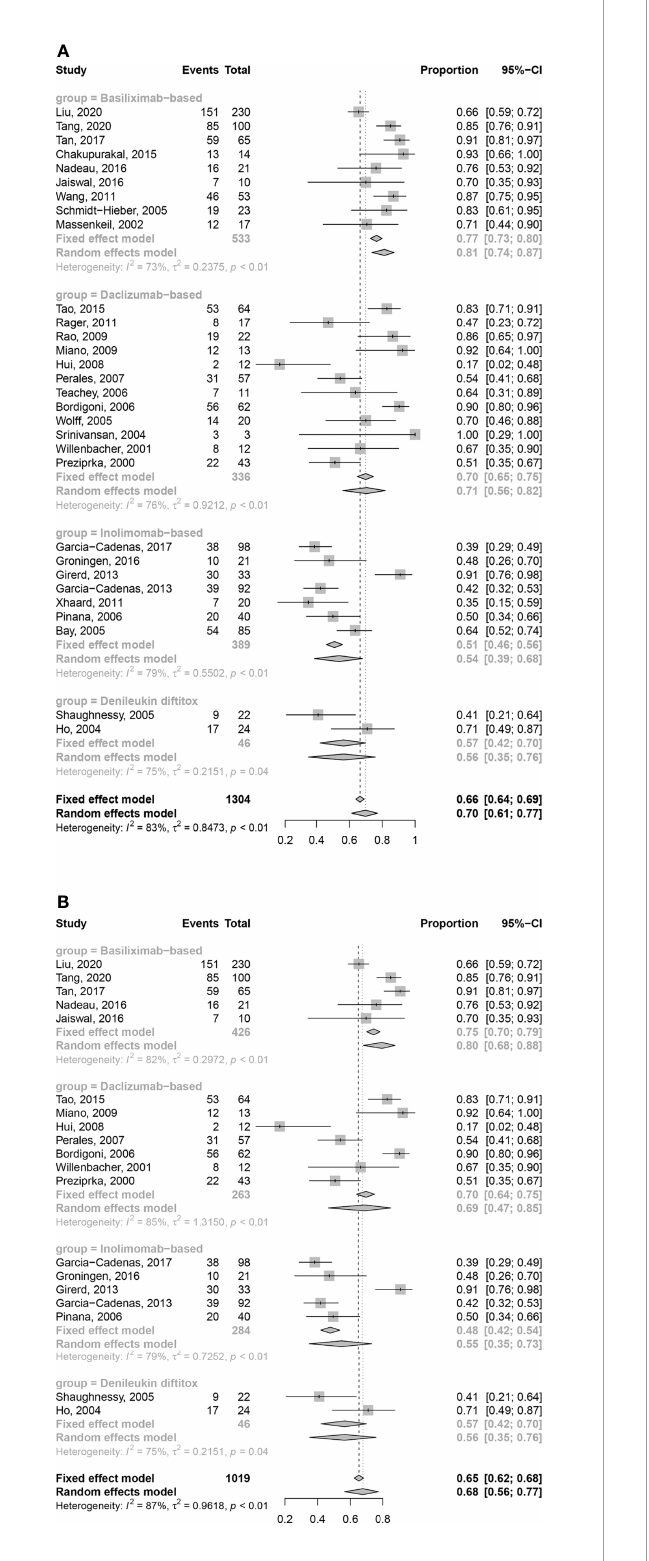
FIGURE 2 | Forest plots of ORR at any time (A) and 1 month (B) after treatment with IL-2RAs.